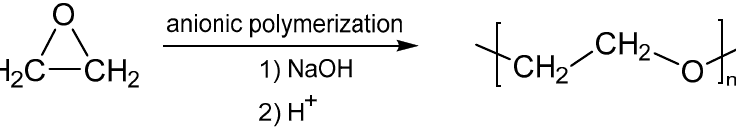
Figure 12. Synthesis of PEG.